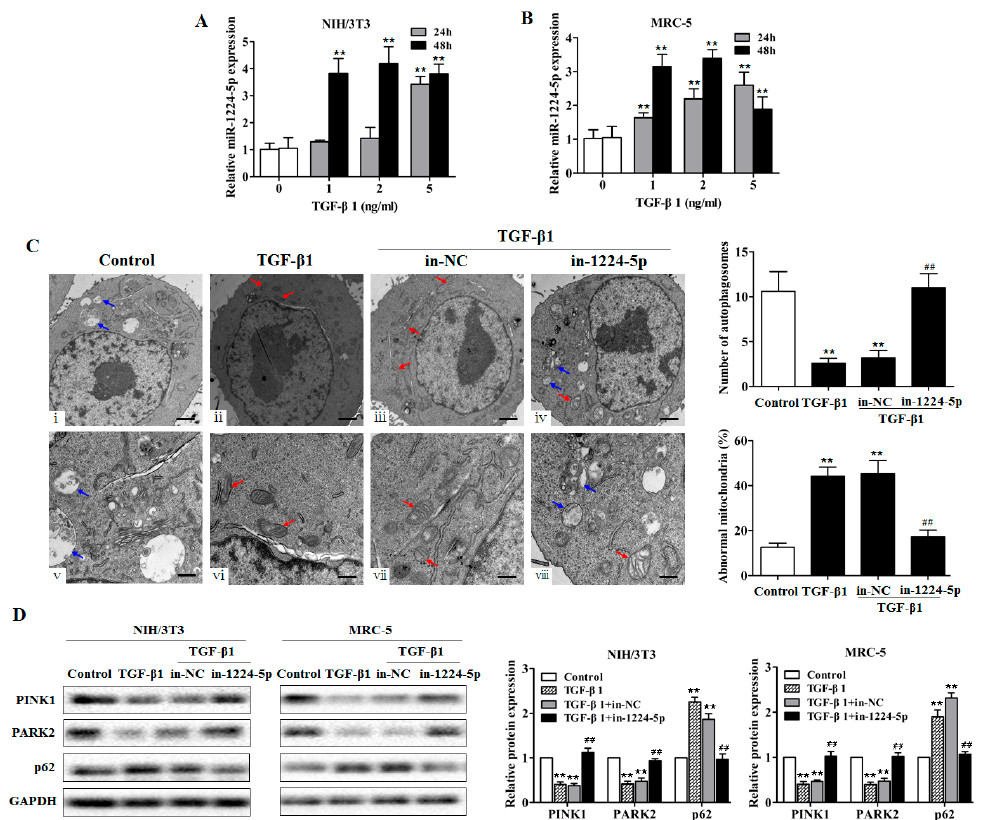
Figure 3. miR-1224-5p suppresses mitophagy in TGF- β 1-exposed fibroblasts. ( A , B ) qRT-PCR analysis of miR-1224-5p levels in fibroblasts (NIH/3T3 and MRC-5) treated with different dose of TGF- β 1 for 24 and 48 h, with ** p < 0.01 vs. the dose 0 group; ( C ) Transmission electron microscopy detection of mitochondrial structure and vacuoles of fibroblasts (NIH/3T3) transfected with miR-1224-5p inhibitor (in-1224-5p) or its negative control (in-NC) then treated with 2 ng/mL TGF- β 1 for 48 h. Blue arrows indicate autophagic vacuoles. Red arrows indicate abnormal mitochondria. Quantification of autophagosomes and percentage of abnormal mitochondria (swollen with an irregular shape and disorganized cristae) from electron microscopy images were performed (five cells each group), with ** p < 0.01 vs. the control group and ## p < 0.01 vs. the TGF- β 1 plus in-NC group. Scale bars, 1 µm (upper panels) and 500 nm (lower panels); ( D ) Western blot and densitometry analysis of the protein expression of PINK1, PARK2, and p62 in fibroblasts (NIH/3T3 and MRC-5) transfected with in-1224-5p or in-NC, with ** p < 0.01 vs. the control group and ## p < 0.01 vs. the TGF- β 1 plus in-NC group. All data are expressed as the mean ± SD of at least three independent experiments.